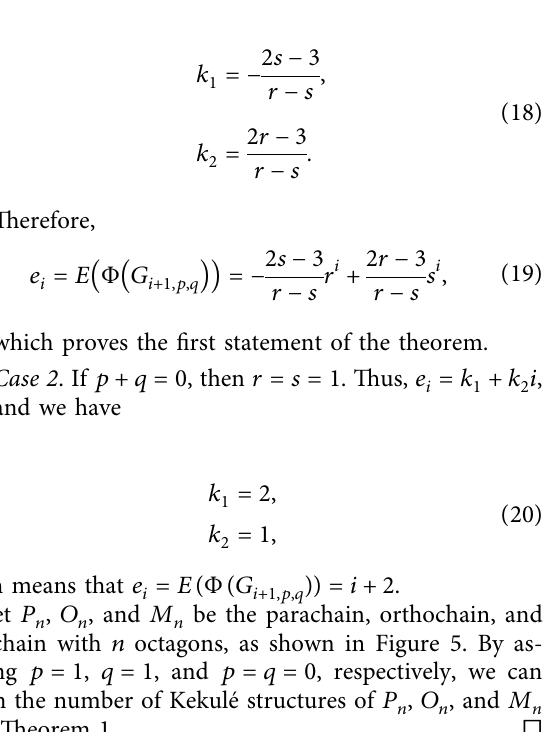
O n , and metachain